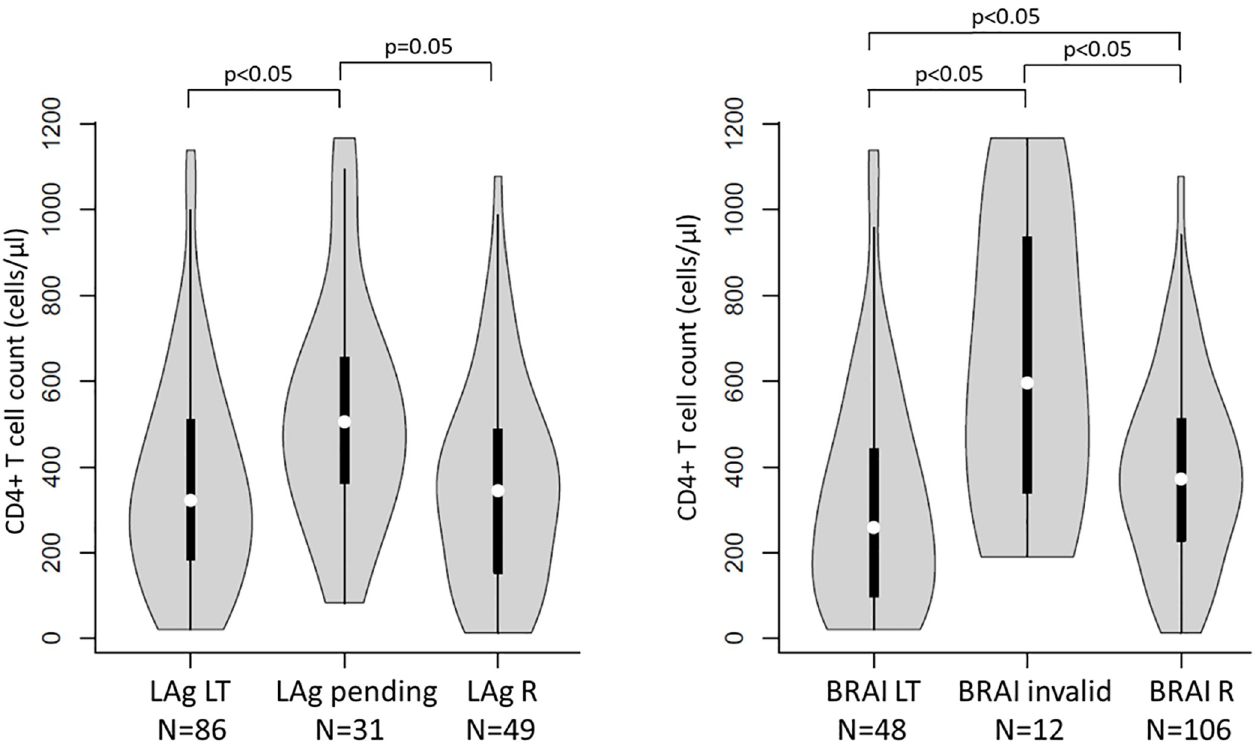
Fig 4. Distribution of CD4+ T cell counts between persons classified as long-term (LT), pending/invalid and recent (R) in the LAg and BRAI assays (left and right panels, respectively). The number of groups indicates the number of persons with CD4+ T cell count measurements within six months after HIV diagnosis. Only significant differences are